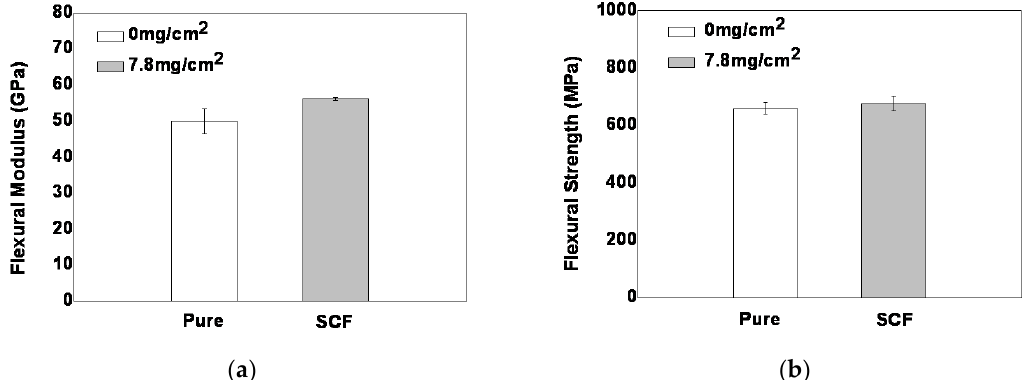
Figure 6. ( a )Flexural modulus and ( b ) flexural strength of NWCT reinforced laminate